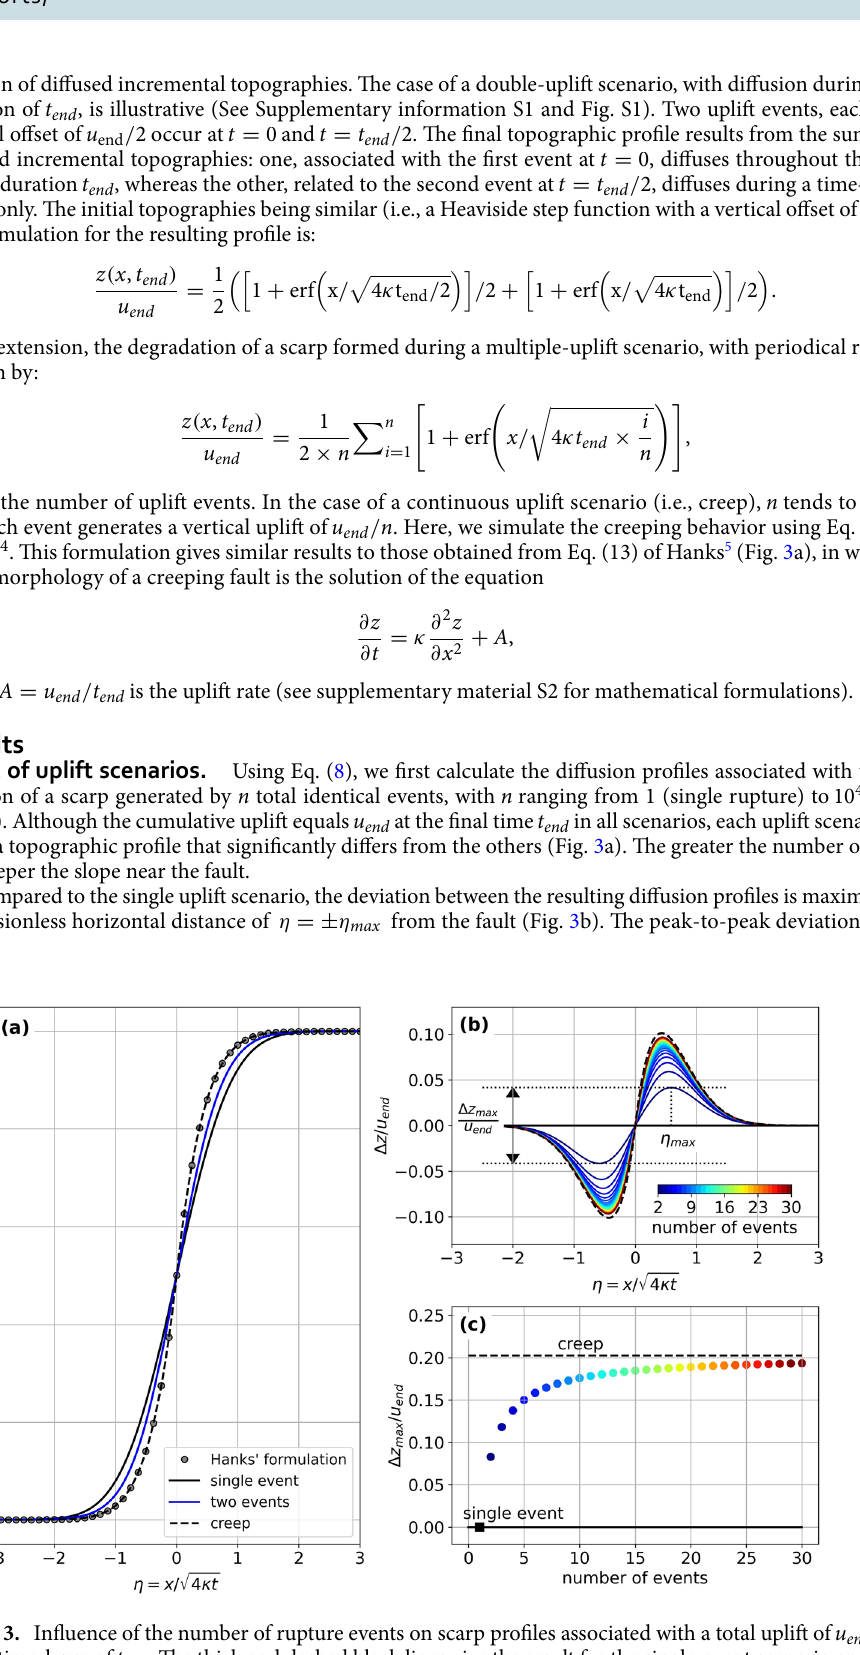
Figure 3. Influence of the number of rupture events on scarp profiles associated with a total uplift of u end and a final time-lapse of t end . The thick and dashed black lines give the result for the single-event scenario and a creeping fault, respectively. The color scale is related to the number of events. ( a ) Calculated dimensionless profiles. Hanks’ formulation 5 is given in Supplementary information S2. ( b ) Topographic deviation with respect to the single-event scenario. ( c ) Variation of the maximum deviation with the number of uplift events. Figure generated using the Python’s matplotlib